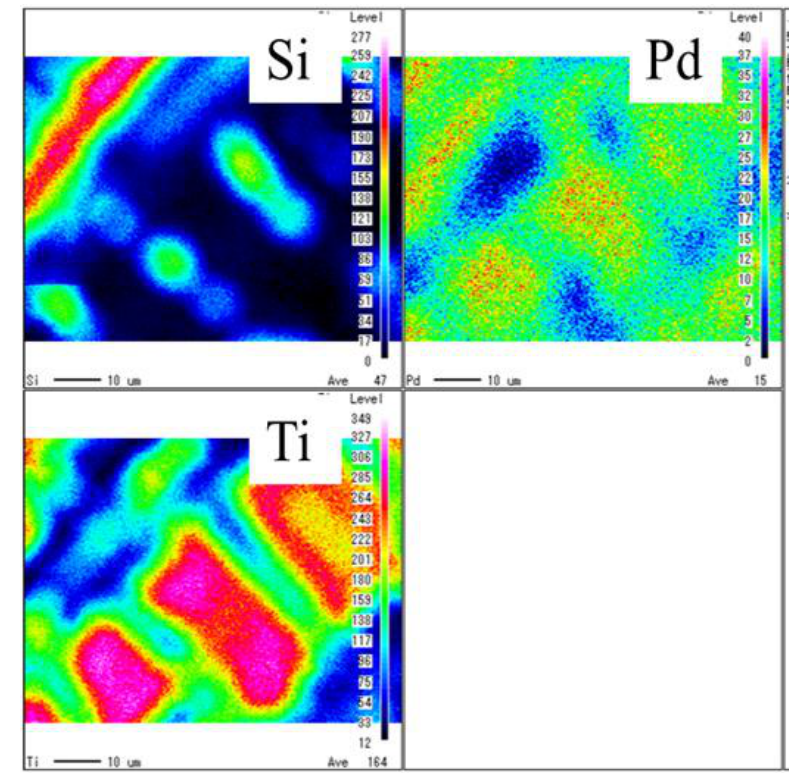
Figure 4. EPMA result of Pd/TiO 2 film coated on netlike glass disc.